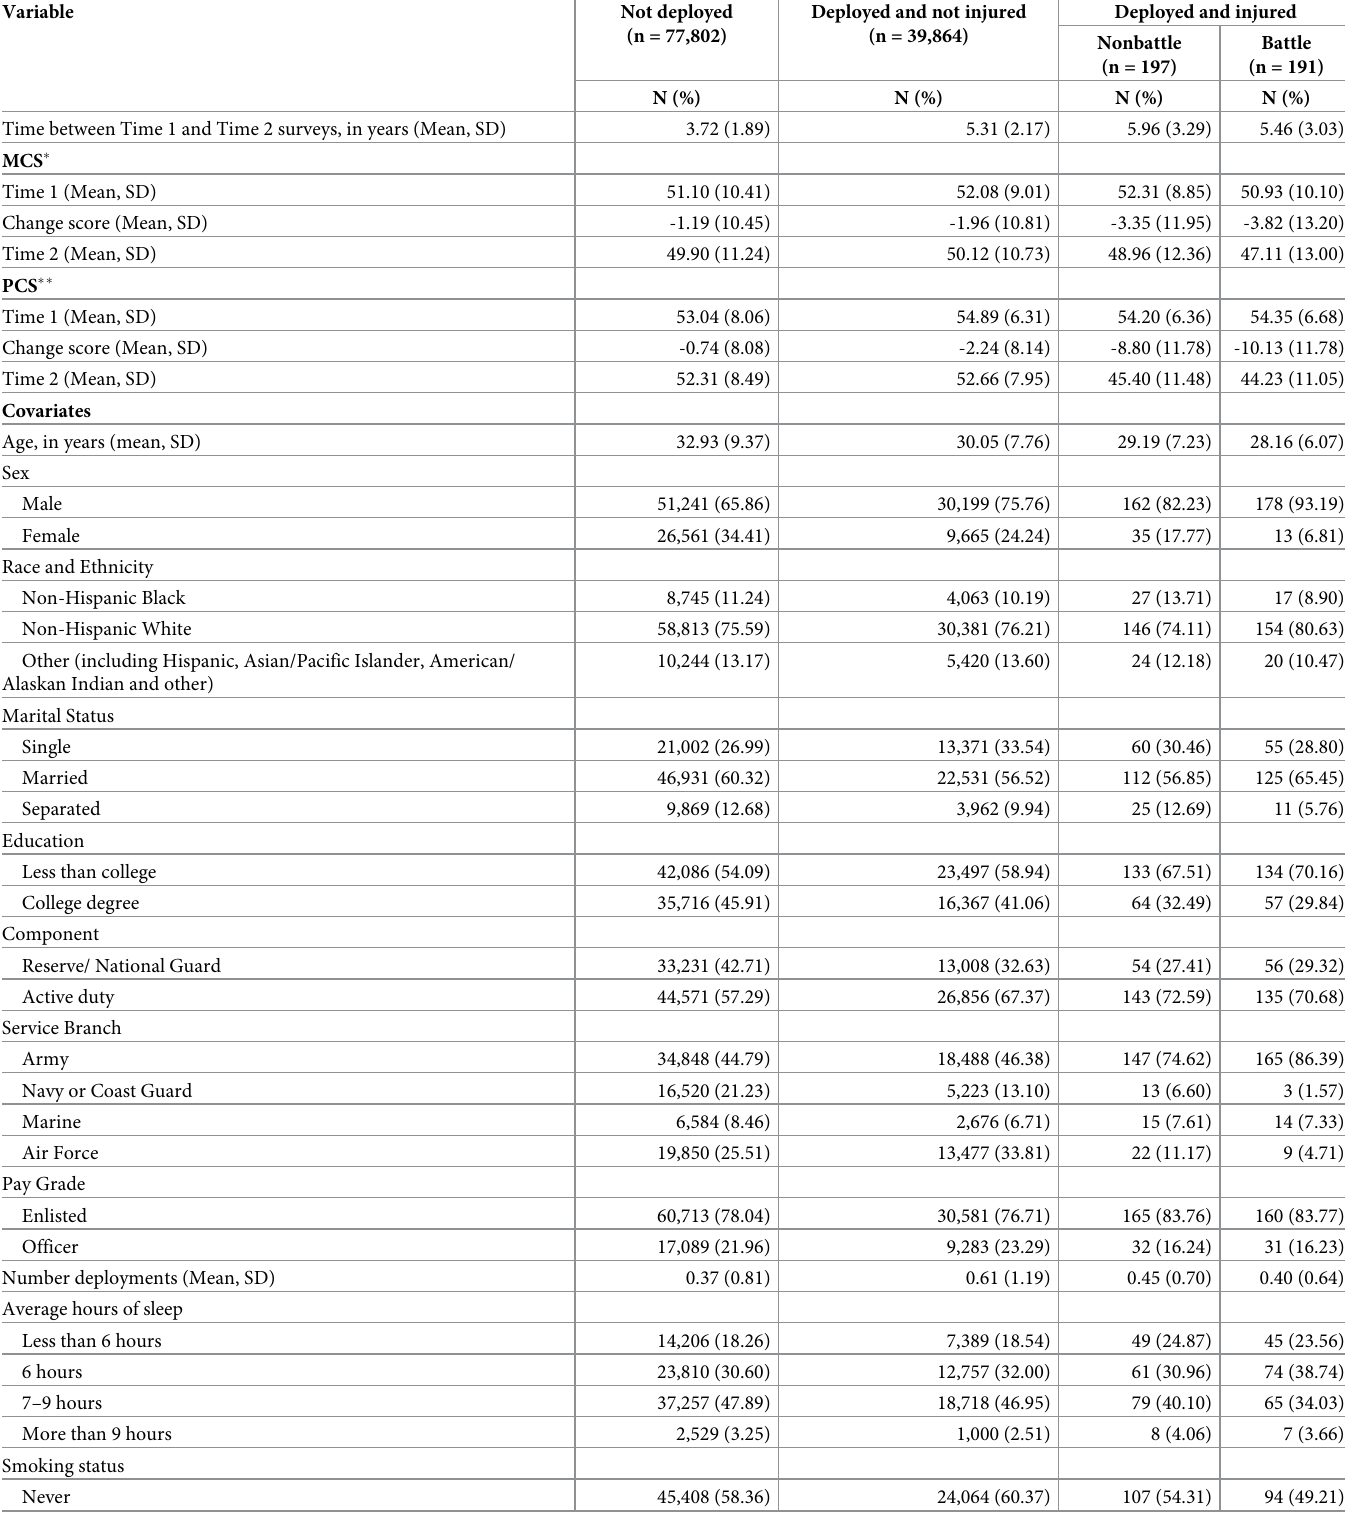
Table 1. Demographic, behavioral, and military characteristics by injury status among Millennium Cohort participants, n =